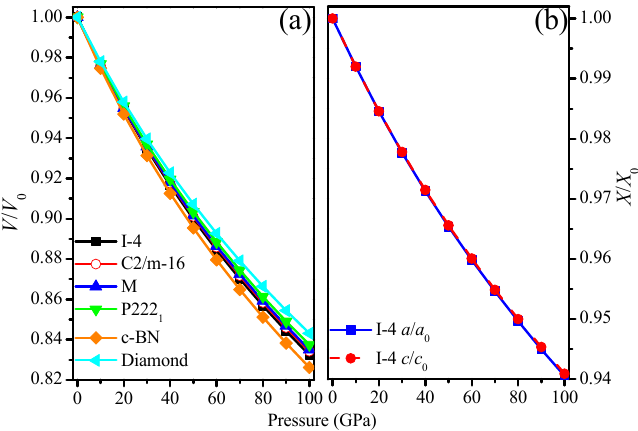
Figure 3. The primitive cell volume V / V 0 as a function of pressure for I4 –carbon, P222 1 -carbon, C2/m-16 carbon, M-carbon, c-BN and diamond ( a ); lattice constants a / a 0 , c / c 0 compression of I4 –carbon as a function of pressure ( b